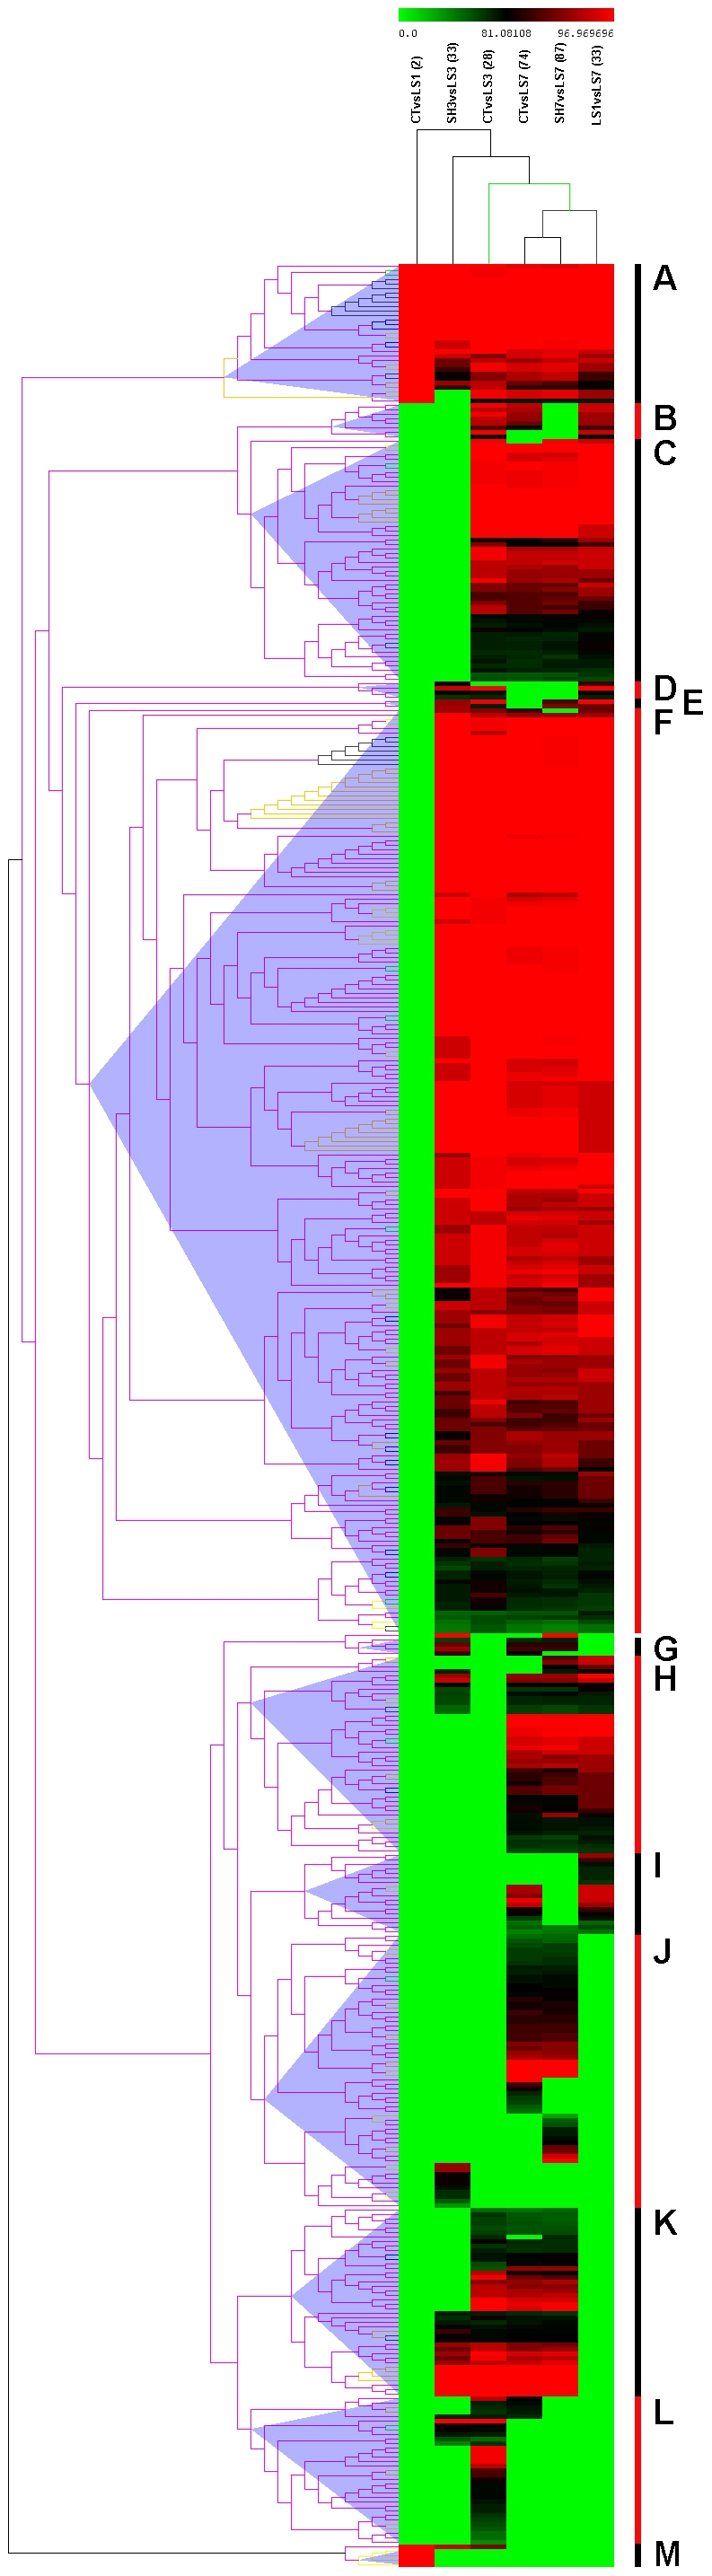
Functional involvement of microRNAs with expression changes.A heat map of unsupervised hierarchical clustering of all Gene Ontology (GO) categories obtained from an enrichment analysis of the microRNAs with significant changes among groups according to the t-test analyses. The GSEA values were obtained using DAVID (http://david.abcc.ncifcrf.gov) algorithms. The gradient represents the percentage of microRNAs targeting each category in each comparison. The GO terms included in each cluster (A to M) are detailed in file S5.